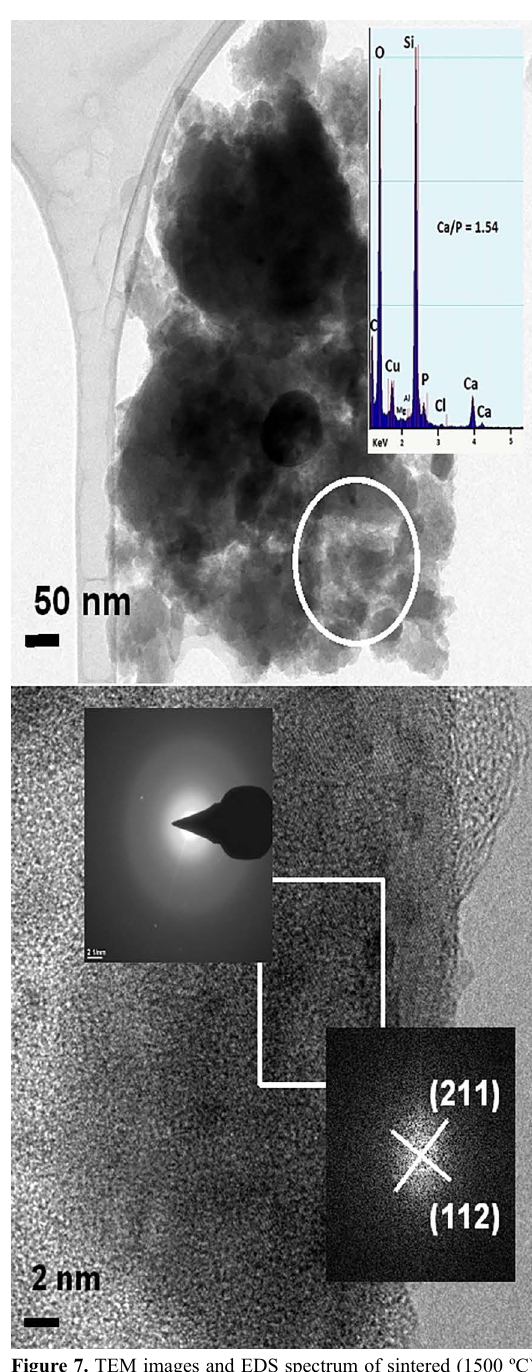
Figure 7. TEM images and EDS spectrum of sintered (1500 ºC) ZrTiO after biomimetic treatment for 21 4